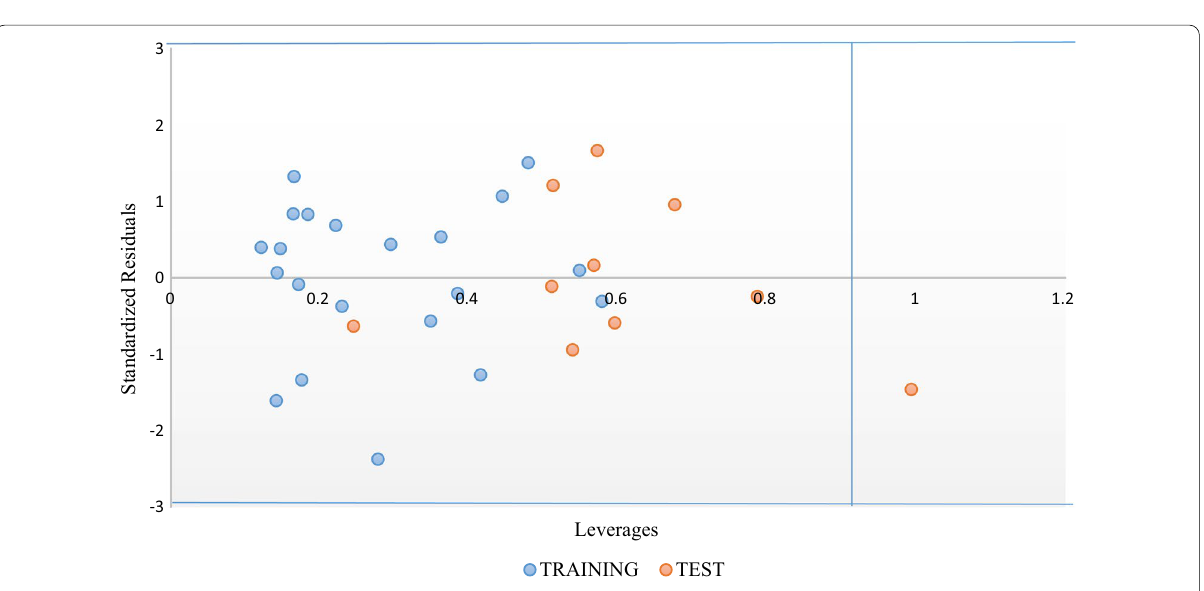
Fig. 2 Williams plot of the model one